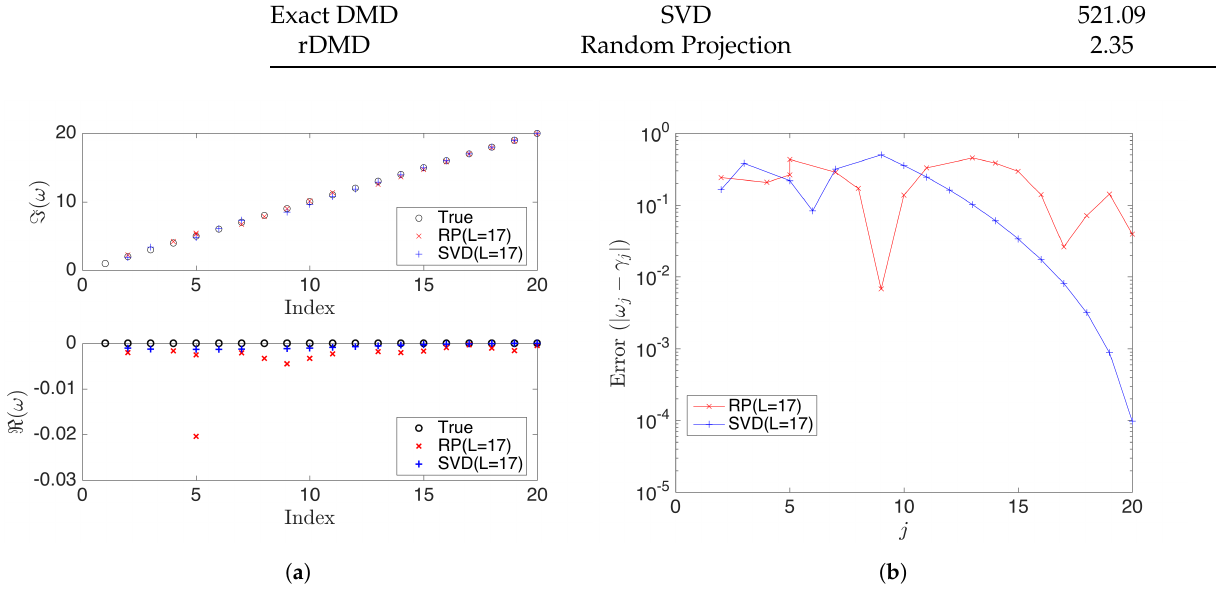
Figure 9. ( a ) Compares the eigenvalues ω j = ln λ j calculated from rDMD (random projection(RP) with L = 17) and exact DMD (SVD projection with L = 17) methods with the expected true values γ j = ji . Here, L = 17 < 20 is the dimension of the projected space. ( b ) Shows the absolute error for the estimated eigenvalues from rDMD and exact